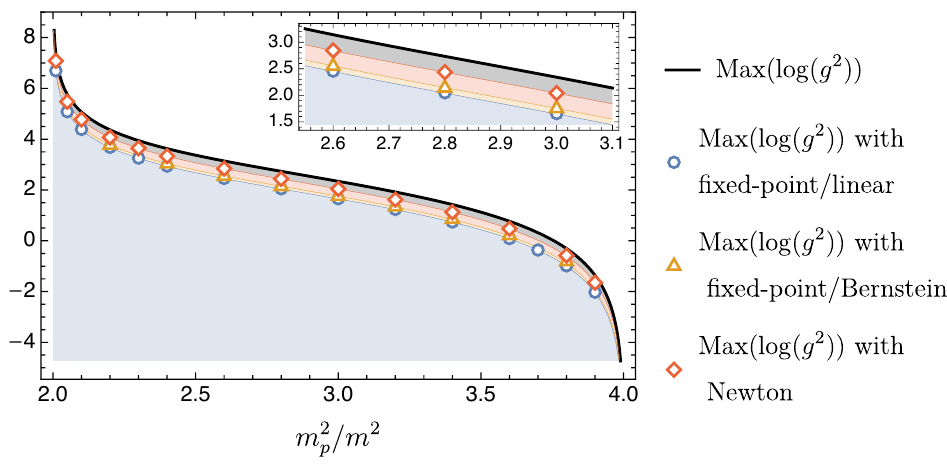
Figure 7 . Maximal coupling as a function of the mass of the bound state. The fixed-point iteration method converges in blue-shaded and yellow-shaded regions. The Newton method extends convergence to the red-shaded region. With finite grids that we used we were not be able to fill in the gray